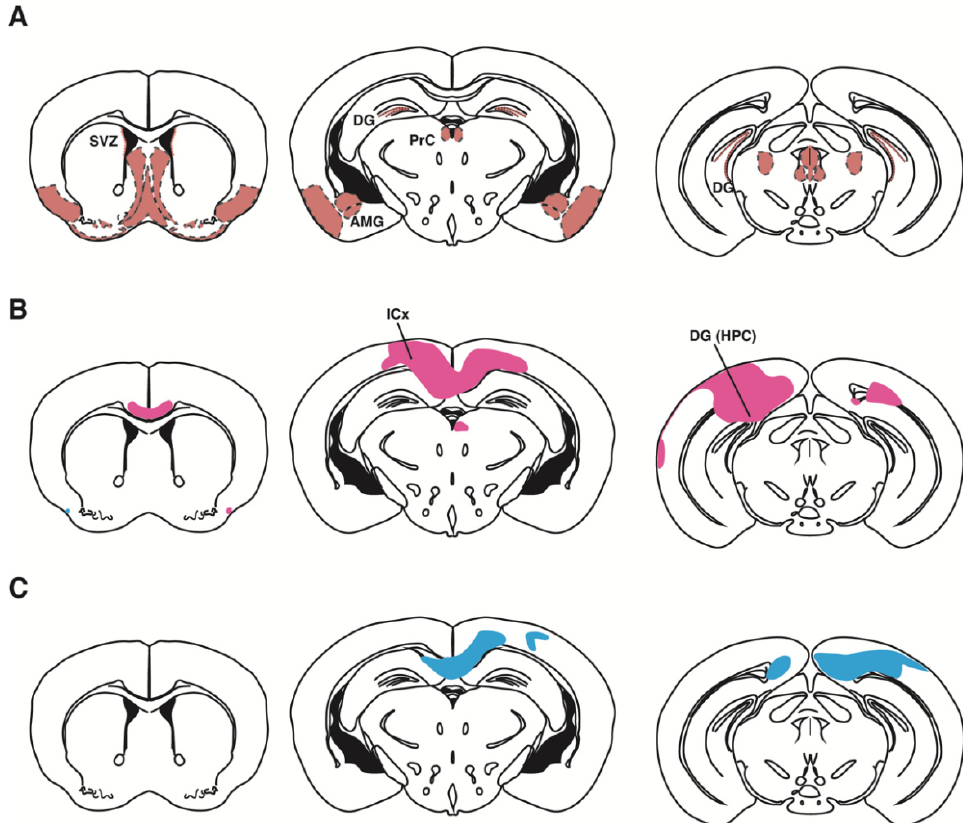
Figure 6. Expression patterns of Pax6 in the mouse brain and the regional volume decrease in the Pax6 heterozygous mutant ( rSey 2 /+ ) rat brain. ( A ) Expression patterns of Pax6 in the adult mouse brain have been redrawn from [25,88,160,161]. The nomenclature and subdivided brain regions are based on previous literature [162]. ( B , C ) The sex differences in regional volume decrease in the brain of the rSey 2 /+ rat compared to the WT using a deformation-based morphometry analysis of MRI data [160]. Pink and blue represent the clusters of regional volume decreases in the brain of female ( B ) and male ( C ) rSey 2 /+ rats compared to WT rats, respectively. The pink region is larger than the blue region. The graphical diagram has been redrawn from [160]. Abbreviations; AMG: amygdala, DG: dentate gyrus, HPC: hippocampus, ICx: isocortex, PrC: precommissural nucleus, SVZ: subventricular zone.